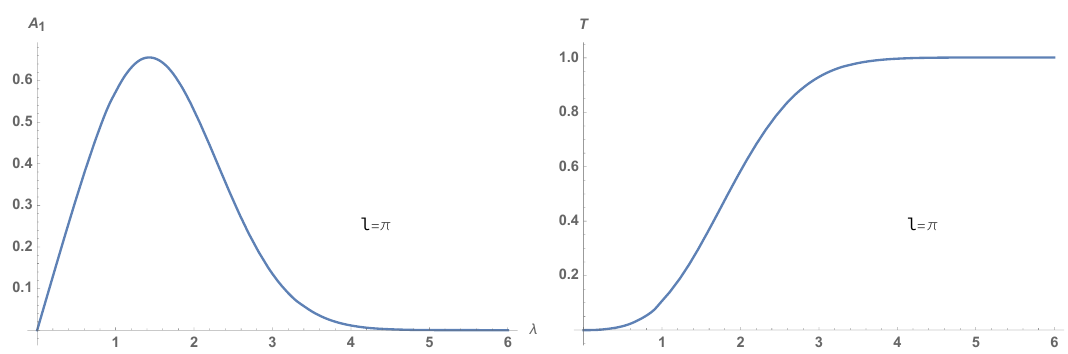
Figure 18 . Pro(cid:12)les for the gauge (cid:12)eld A toy